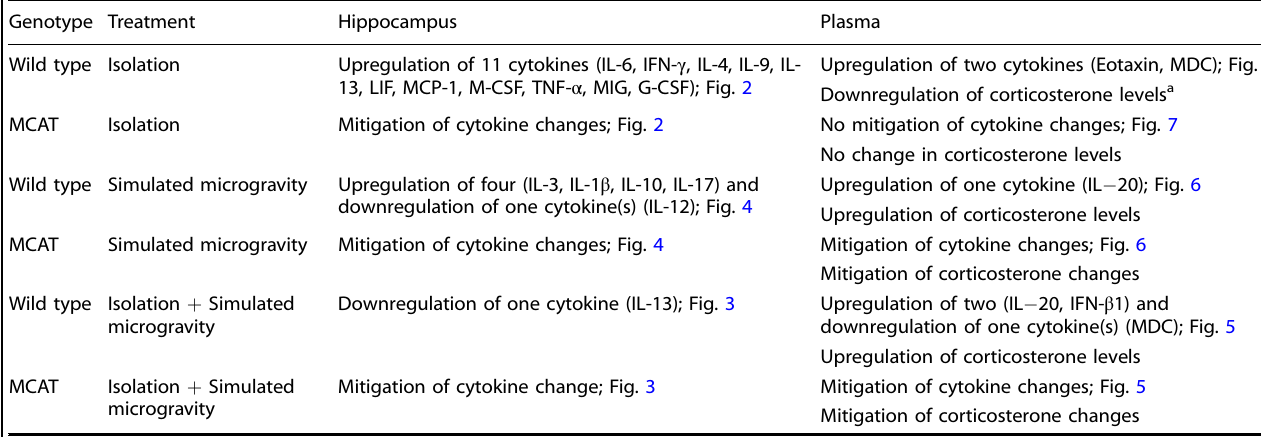
Table 1. Summary of the response of each genotype to isolation, simulated microgravity, or both.